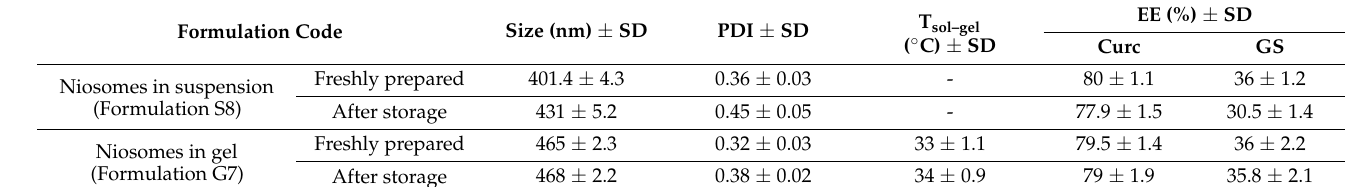
Table 3. Evaluation of physical stability of selected niosomal formulations and in situ thermosensitive gel thereof after storage at 4 ◦ C for one month.